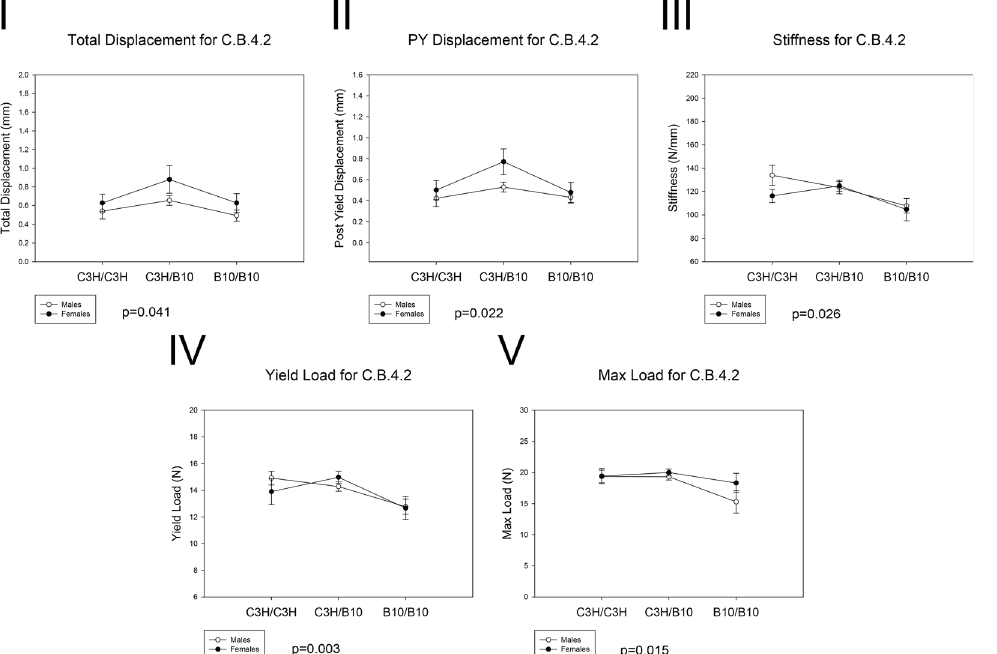
Fig 4. Whole Bone Mechanical Performance of C.B.4.2 mice. The effects of sex and genotypes on (I) Total displacement, p = 0.041, B10/B10 < C3H/B10 for both sexes; (II) PYD, p = 0.022, B10/B10 < C3H/B10 for both sexes, (III) Stiffness, p = 0.026, B10/B10 < C3H/B10 for both sexes; (IV) Yield load, p = 0.003, B10/B10 < C3H/B10 and C3H/C3H for both sexes, (V) Max load, p = 0.015, B10/B10 < C3H/B10 and C3H/C3H for both sexes. Values are means ±